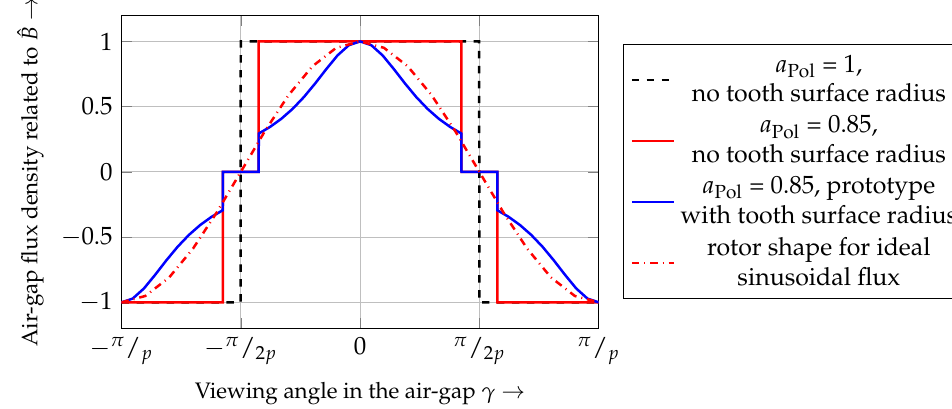
Figure 3. Air-gap flux density for different rotor